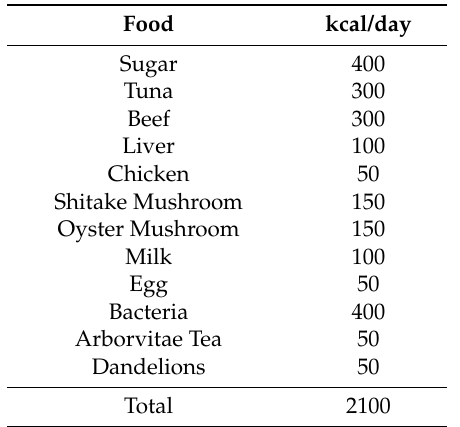
Table 1. Number of kilocalories per day provided by the alternative food sources in a representative balanced diet using US RDA data.